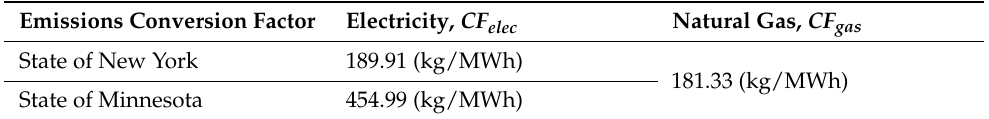
Table 4. U.S. Emission conversion factors by fuel [28].